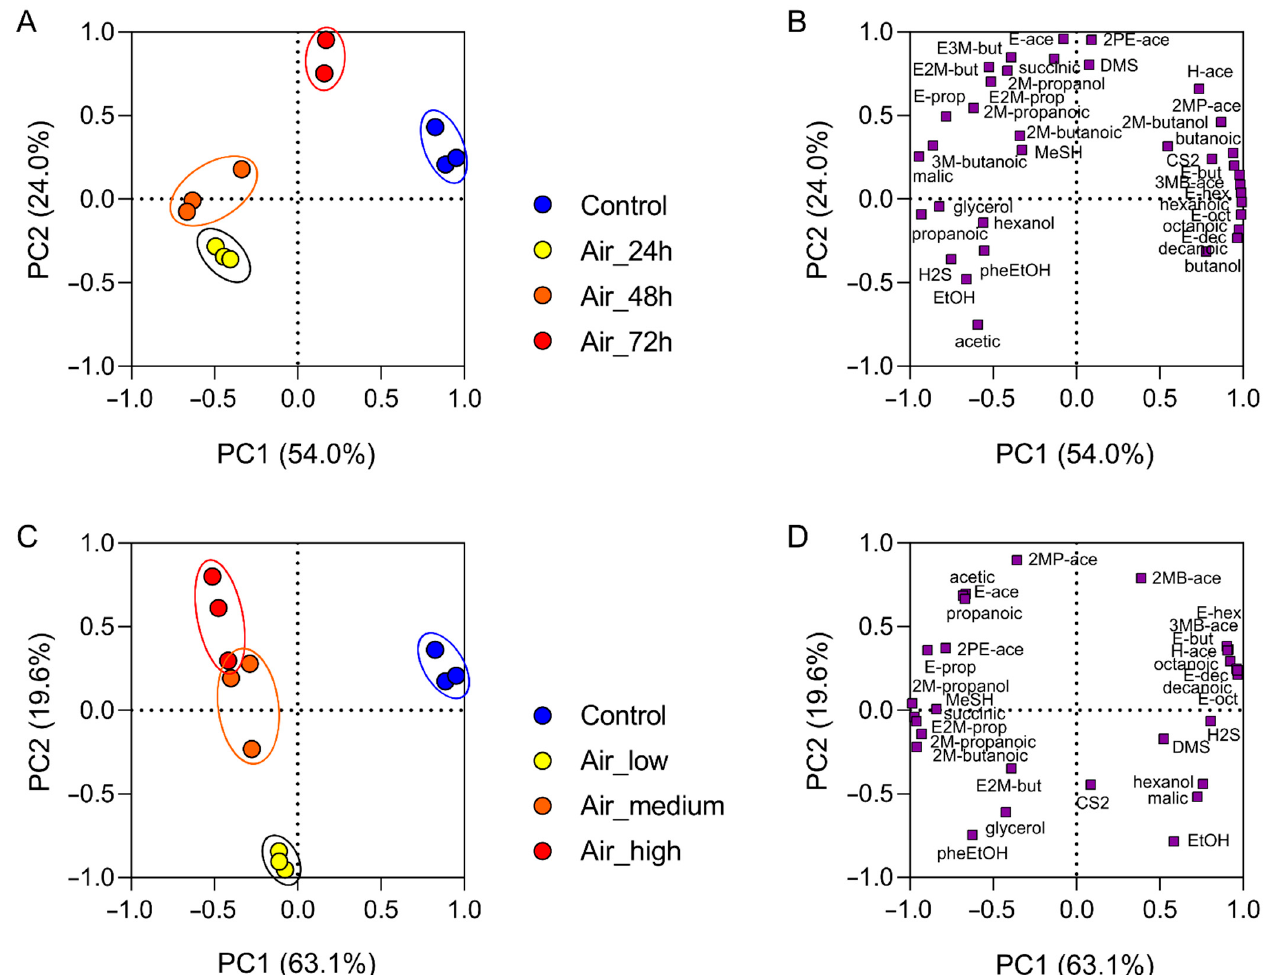
Figure 6. Principal component analysis for ferments from the 2019 and 2020 vintages. ( A ) scores for 2019 wines, ( B ) loadings for 2019 wines, ( C ) scores for 2020 wines, ( D ) loadings for 2020 wines. Individual winemaking replicates are shown, with ellipses drawn to visually indicate the difference between replicates. 2M-butanoic, 2-methyl butanoic acid; 3M-butanoic, 3-methyl butanoic acid; 2M-butanol, 2-methyl butanol; 2MB-ace, 2-methylbutyl acetate; 2M-propanoic, 2-methyl propanoic acid; 2M-propanol, 2-methyl propanol; 2MP-ace, 2-methylpropyl acetate; 2PE-ace, 2-phenylethyl acetate; 3MB-ace, 3-methylbutyl acetate; 3M-butanol, 3-methyl butanol; acetic, acetic acid; butanoic, butanoic acid; butanol, butanol; CS2, carbon disulfide; decanoic, decanoic acid; DMS, dimethyl sulfide; EtOH, ethanol; E2M-but, ethyl-2-methyl butanoate; E3M-but, ethyl-3-methyl butanoate; E2M-prop, ethyl-2-methyl propanoate; E-ace, ethyl acetate; E-but, ethyl butanoate; E-dec, ethyl decanoate; E-hex, ethyl hexanoate; E-prop, ethyl propanoate; E-oct, ethyl octanoate; glycerol, glycerol; H2S,